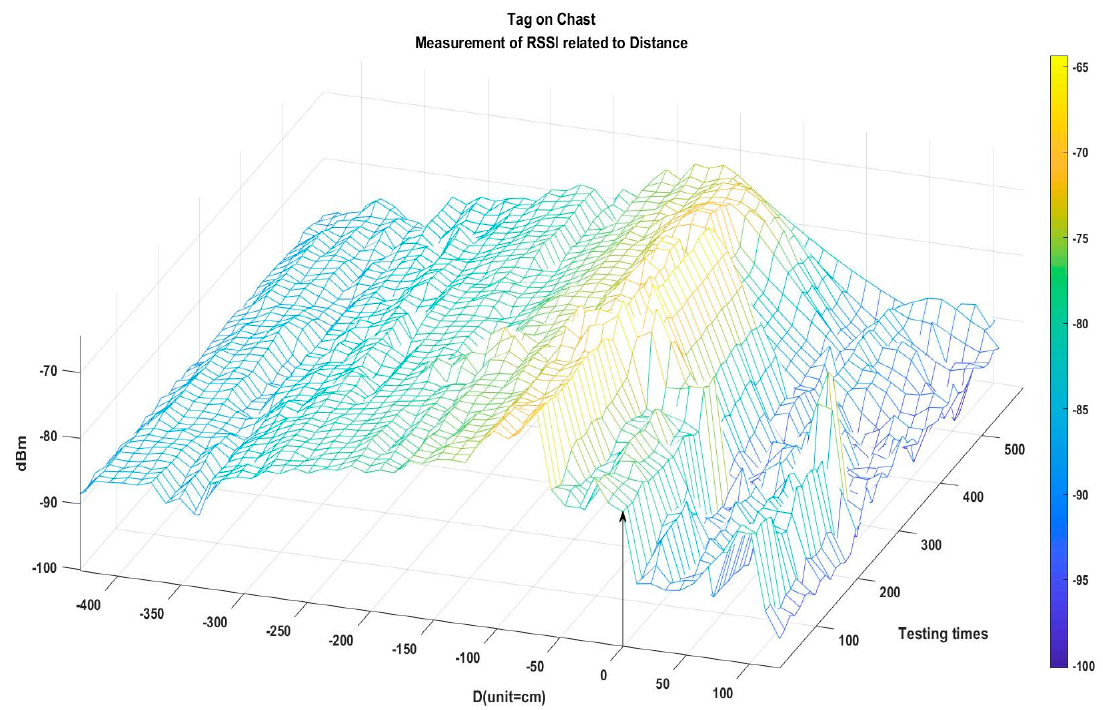
Figure 12. Static experiment to test the strength of RSSI at different locations.